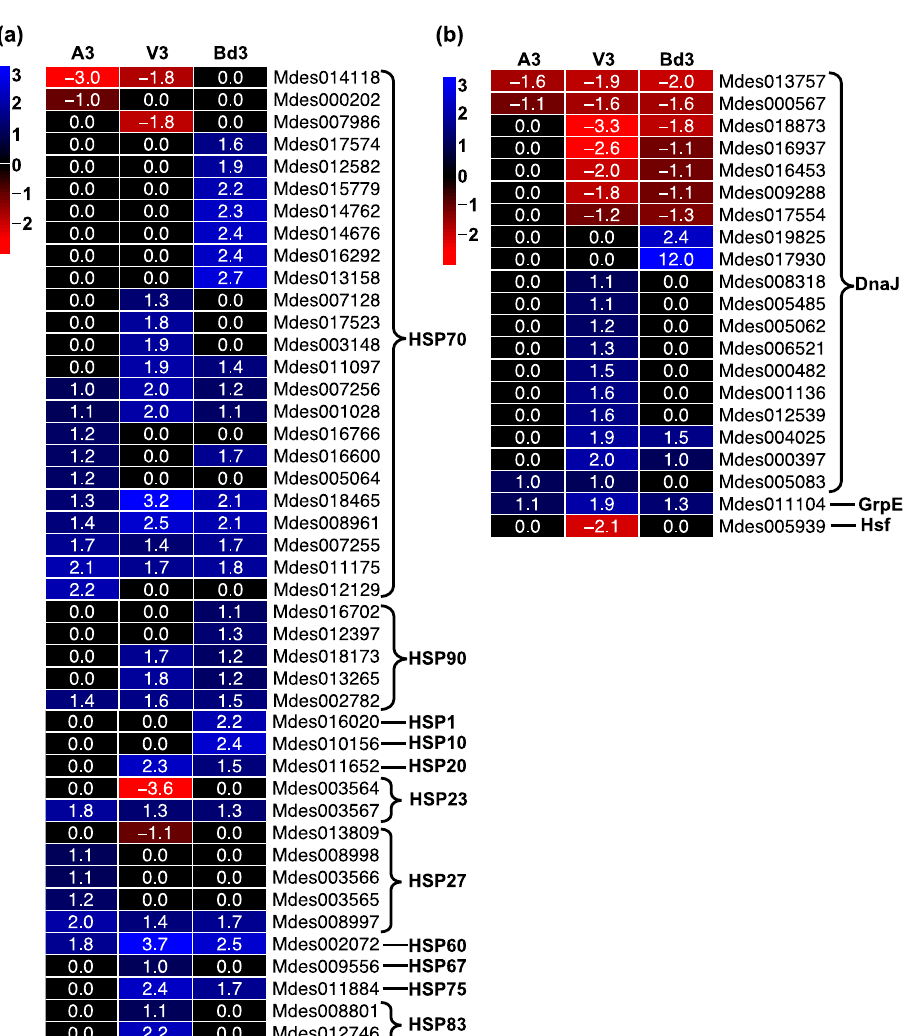
Figure 9. Differential expression of heat shock proteins in Hessian fly larvae 3 days after hatch (DAH). Heatmaps depict genes encoding differentially expressed heat shock proteins (HSP) in avirulent (A3), virulent (V3), and Bd3 larval transcriptomes, and grouped based on HSP families. ( a ) Expression of genes encoding HSP70, HSP90, small heat shock proteins (HSP1, HSP10, HSP20, HSP23, HSP27), HSP60, HSP67, HSP75, and HSP83. ( b ) Differentially expressed genes encoding the cochaperones DnaJ family, GrpE, and Heat shock factors (Hsf). Log2 fold-change RNA-Seq values are shown within each cell of the heatmap. Blue represents up-regulated genes, and red represents the down-regulated genes, while genes not differentially expressed at a particular time-point are indicated in black.